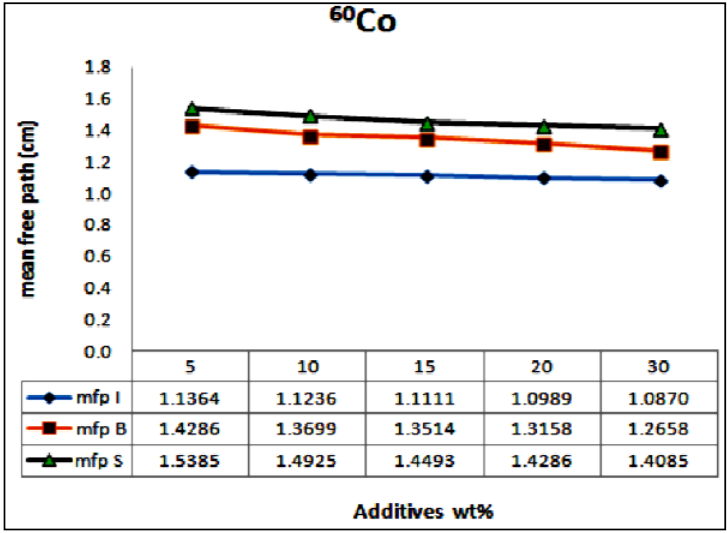
Figure9. Variation of mfp as a function of the additives wt % for the 60 Co source, µI, µB and µS standing for the attenuation coefficients for the samples of iron particulates, steel balls and steel slags, respectively .